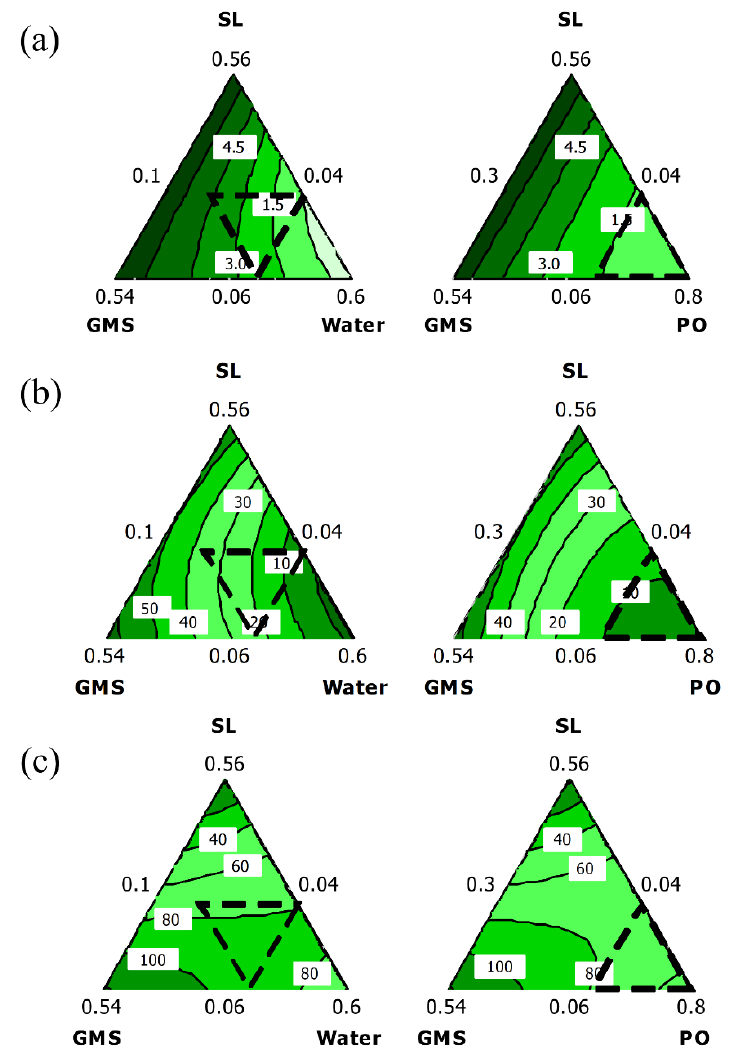
Figure 1. Mixture contour plots of predicted responses of the formulations: ( a ) firmness, ( b ) spread- ability, and ( c ) oil binding capacity (OBC).